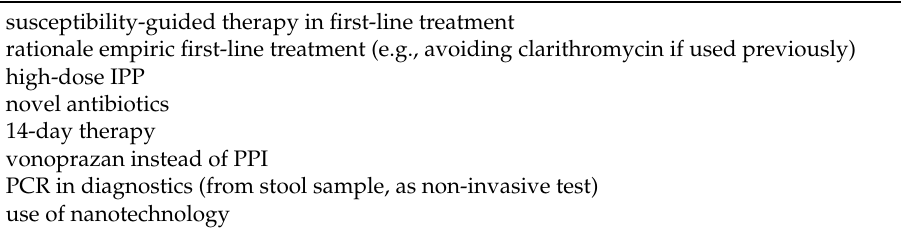
Table 1. Future directions of personalized approach in treatment of H. pylori